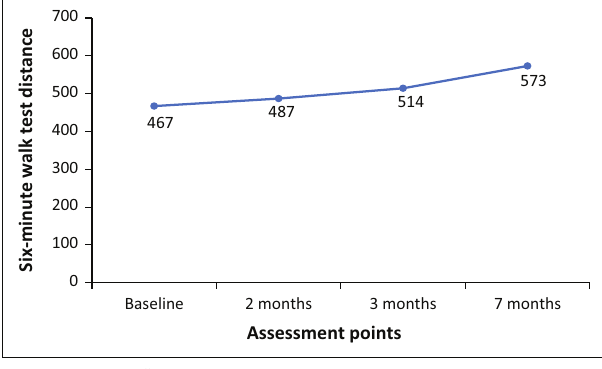
FIGURE 2: Changes in distance walked by Mrs K over a 7-month follow-up TABLE 1: Changes in peak expiratory flow rate and six-minute walk test distance for Mr M over a 6-month follow-up period. Assessment points after hospital